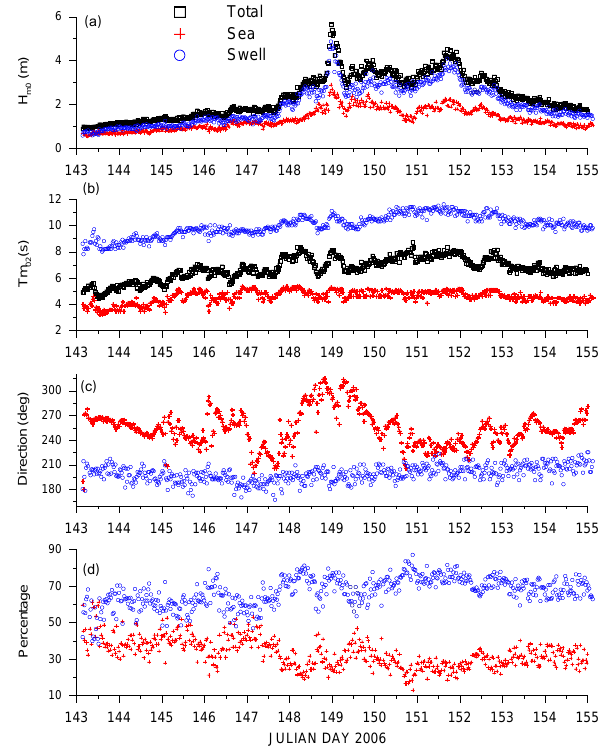
Figure 2. Variation of (A) Significant wave height, sea and swell height, (B) Average mean Fig. 2. Variation of (a) Significant wave height, sea and swell wave period, mean wave period of sea, mean wave period of swell (C) Mean wave direction height. (b) Average mean wave period, mean wave period of sea, of swell and mean wave direction of sea (D) Percentage of sea and swell mean wave period of swell. (c) Mean wave direction of swell and mean wave direction of sea. (d) Percentage of sea and